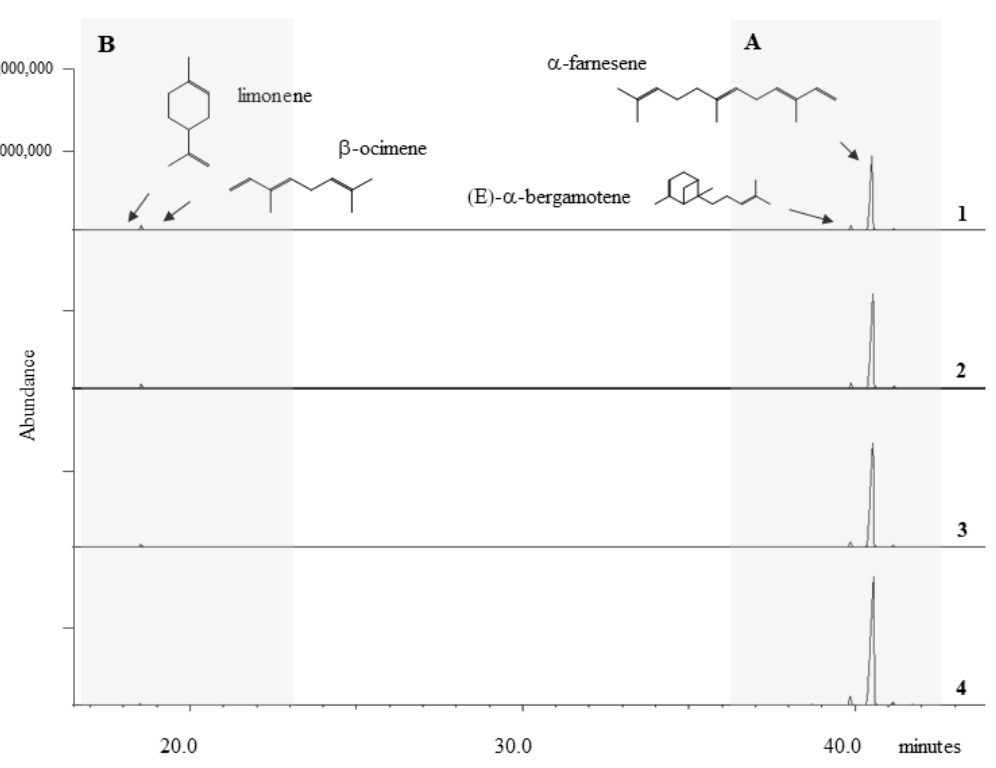
Figure 2. Representative HS-SPME-GC/MS traces from Vitis vinifera plants at four different times: (1) before inoculation, (2) 24 h, (3) 48 h and (4) 72 h after inoculation. The grey zone A highlights the presence of monoterpenes limonene and β -ocimene, while the grey zone B highlights the presence of sesquiterpenes (E) α -bergamotene and α -farnesene.